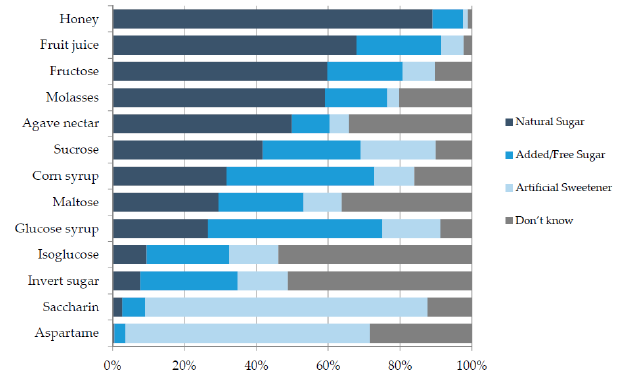
Figure 2. Consumer classification of sugars and sweeteners, n = 443.